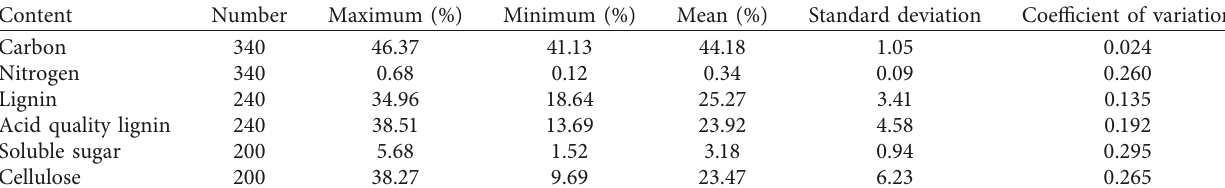
Figure 1: (a) Schematic of the scanning position on rapeseed stalks. (b) Spectra of the samples. Table 1: Statistical results of six rapeseed stem